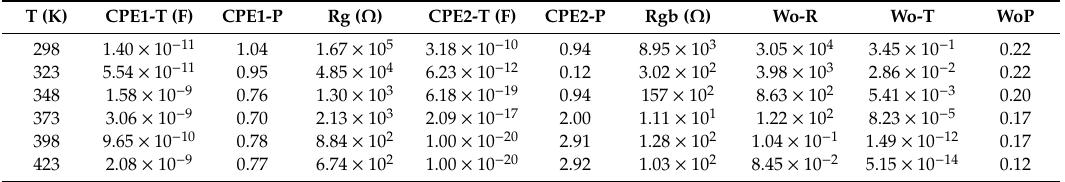
Table A2. Circuital element values from equivalent circuit fitting of the experimental results for